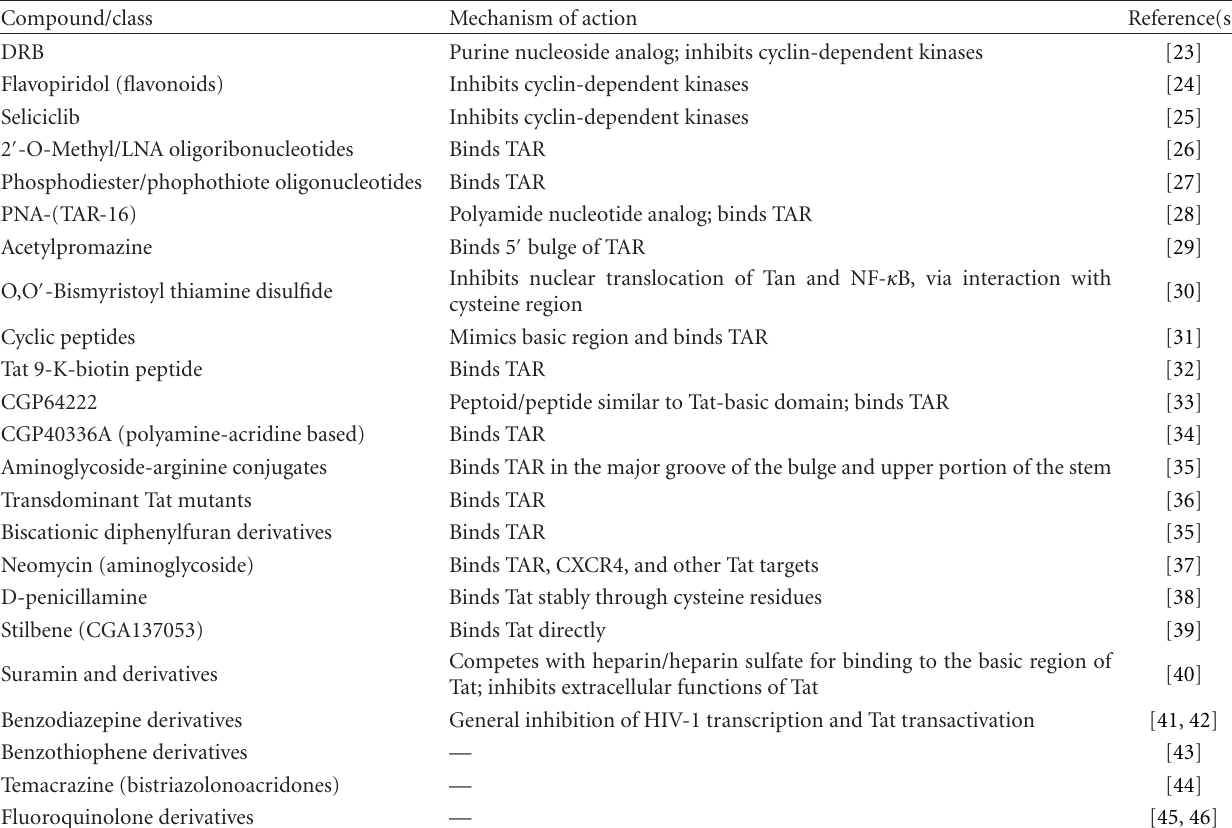
Table 2: Tat-based